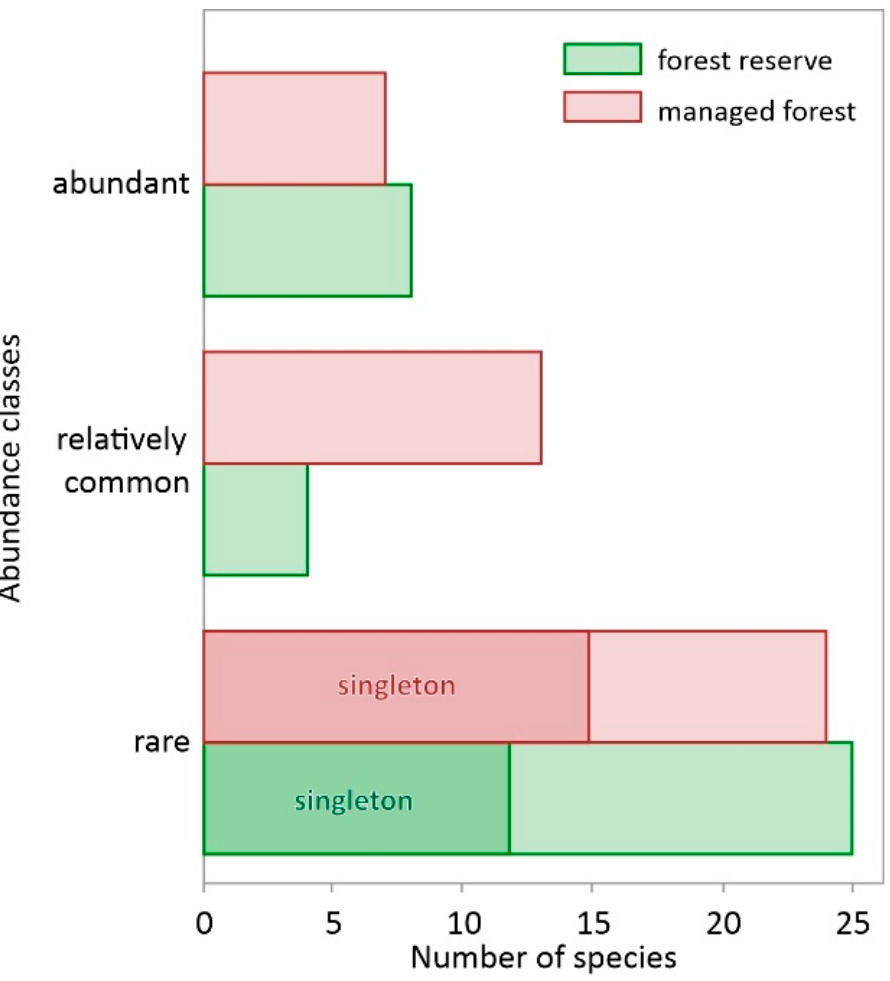
Figure 3. Distribution of the number of beetle species caught in pitfall traps by abundance classes.